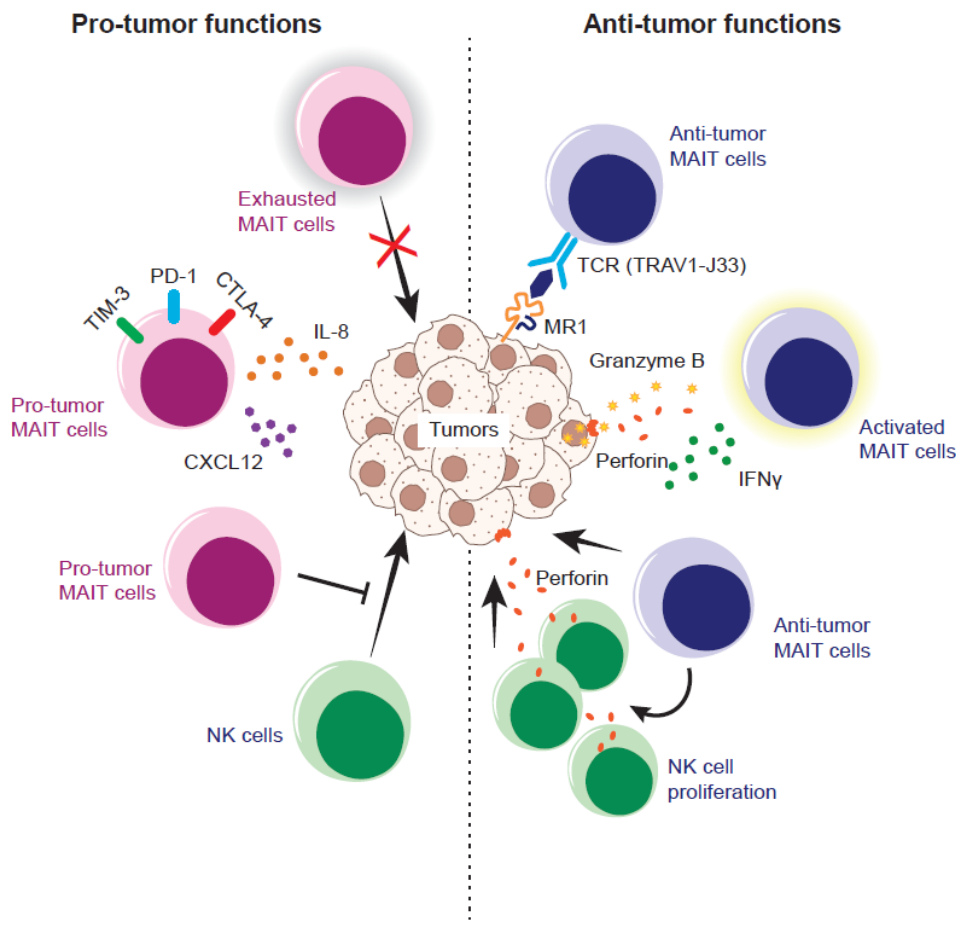
Figure 1. Pro- and anti-tumor nature of MAIT cells in the murine tumor model. Exhausted MAIT cells fail to control tumor growth and/or pro-tumor MAIT cells instigate tumor growth and/or metastasis by secreting IL-18 and/or CXCL12. Pro-tumor MAIT cells also inhibit the anti-tumor function of NK cells through suppressing the production of IFN- γ and degranulation. In contrast, anti-tumor MAIT cells recognize the ligand (5-OP-RU and/or tumor-derived ligands) loaded onto MR1 on the tumor cells via a T cell receptor (TCR) and stimulate the proliferation of NK cells armed with an effector molecule, perforin, which, in turn, results in tumor lysis. Alternatively, anti-tumor MAIT cells could recognize the tumor cell in a TCR-independent fashion and lyse the tumor cells.